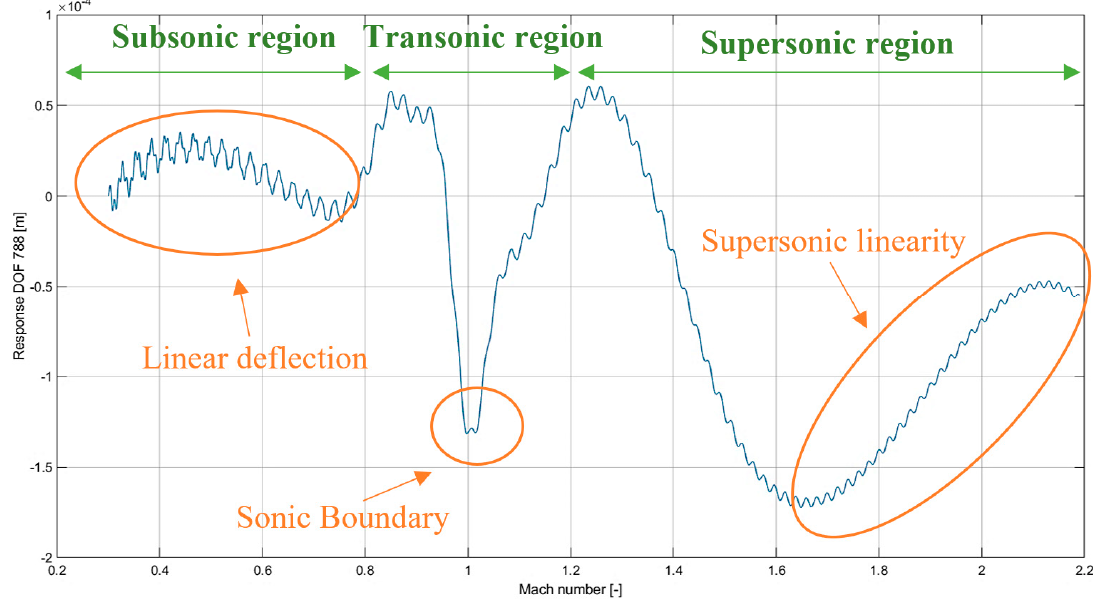
Figure 40. Deflection of the nosecone with respect to the Mach number with annotated regions and specific regimes.